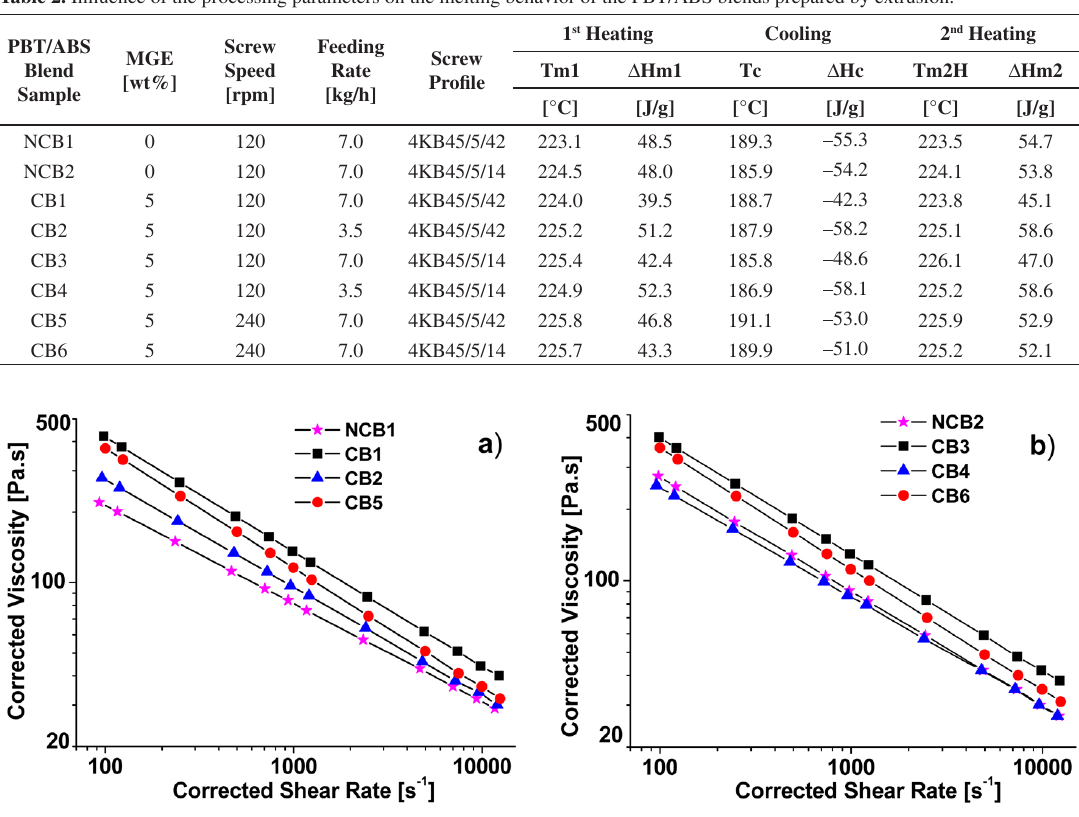
Figure 4. Shear viscosity as function of shear rate curves of the PBT/ABS blends: a) PBT/ABS blends prepared using the screw profile 4KB45/5/42 and processing conditions NCB1, CB1, CB2 and CB5; b) PBT/ABS blends prepared using the screw profile 4KB45/5/14 and processing conditions NCB2, CB3, CB4 and CB6, all conditions according with Table